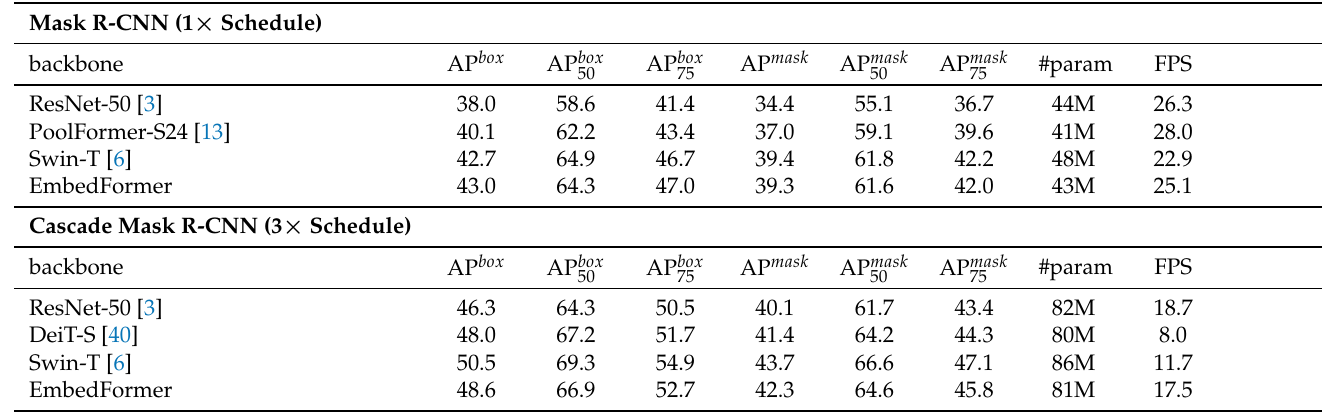
Table 2. The object detection and segmentation results on COCO using Mask R-CNN and Cascade Mask R-CNN. The results of FPS are tested on one piece of RTX-3090.